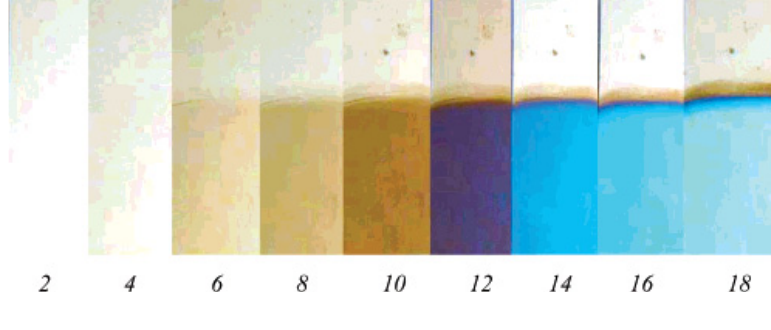
Figure 4. Interference colors of films of microfibrillated cellulose (MFC) and the polyelectrolyte polyethyleneimine (PEI) as a function of the number of layers. For example, 12 in this figure means a combination of six layers of PEI and six layers of MFC.